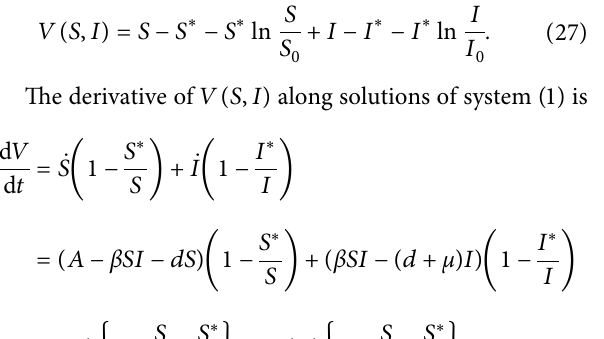
. P indicates that the 0 0 indicates 1 2